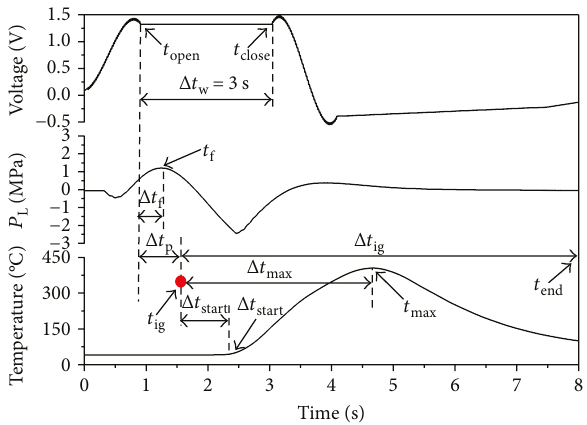
Figure 2: Schematic of ignition time